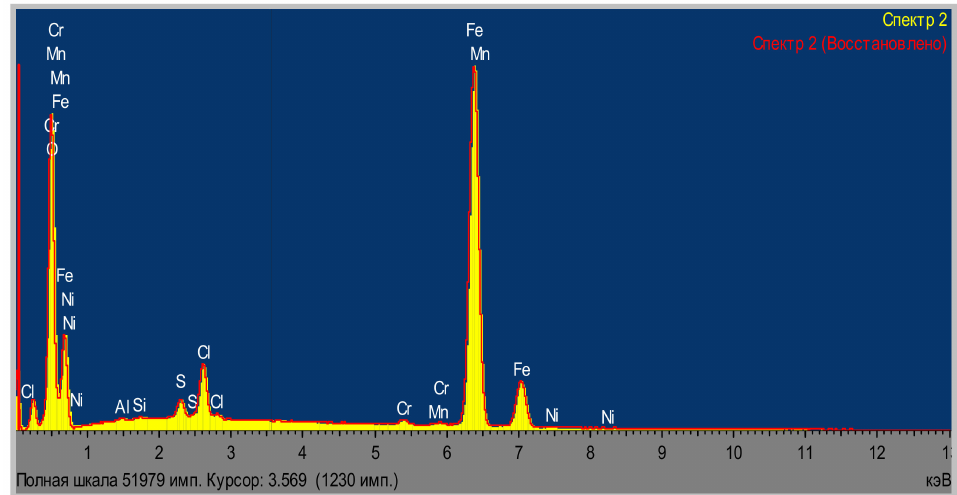
Figure 5. X-ray fluorescence spectrum of magnetic composite. The full scale of 51,979 pulses. The cursor is 3569 (1230 pulses).